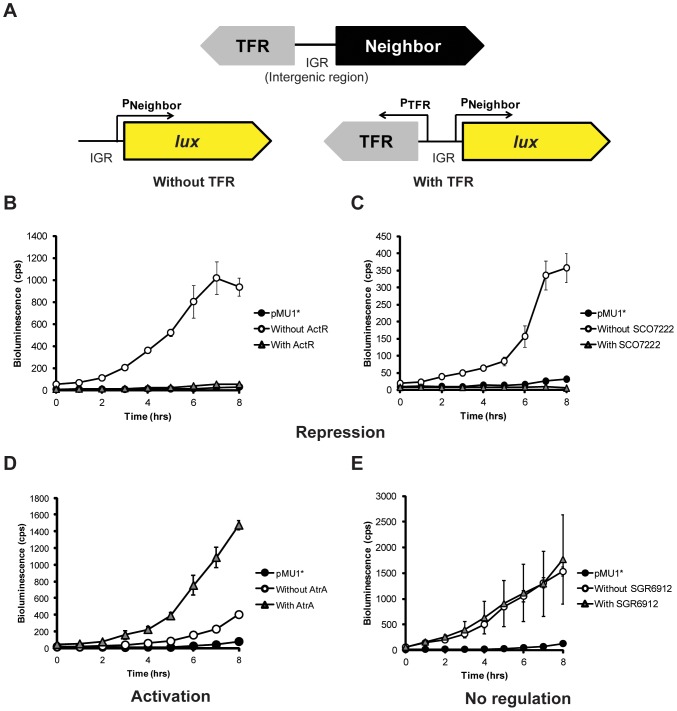
ActR, SCO7222, AtrA, and SGR6912 possess different regulatory effects on the divergent neighbors.(A) Two reporter plasmids were constructed for each TFR. For these plasmids, expression of the lux operon is driven by the promoter of the divergently transcribed neighboring gene in the absence (Without TFR) or in the presence (With TFR) of the TFR-encoding gene in cis. These two plasmids were introduced separately into a heterologous Streptomyces host for comparing their bioluminescence production as a function of time. Average bioluminescence values, measured in counts per second (cps), as well as +/− standard deviation of the values were obtained from at least three independent readings. Compared to the “Without TFR” constructs, three different outcomes were displayed when the cognate TFRs were expressed in cis. (B) Negative effect on luminescence by ActR. (C) Negative effect on luminescence by SCO7222. (D) Positive effect on luminescence by AtrA. (E) No effect on luminescence by SGR6912.